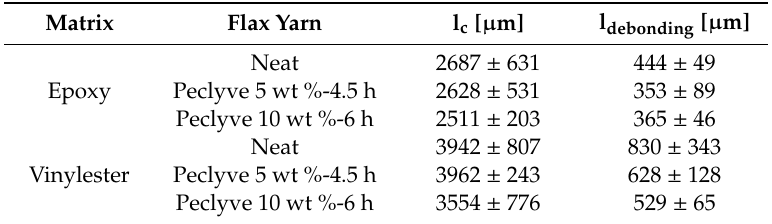
Table 6. Critical fragment length and debonding length values for the di ff erent single yarn composites. Matrix Flax